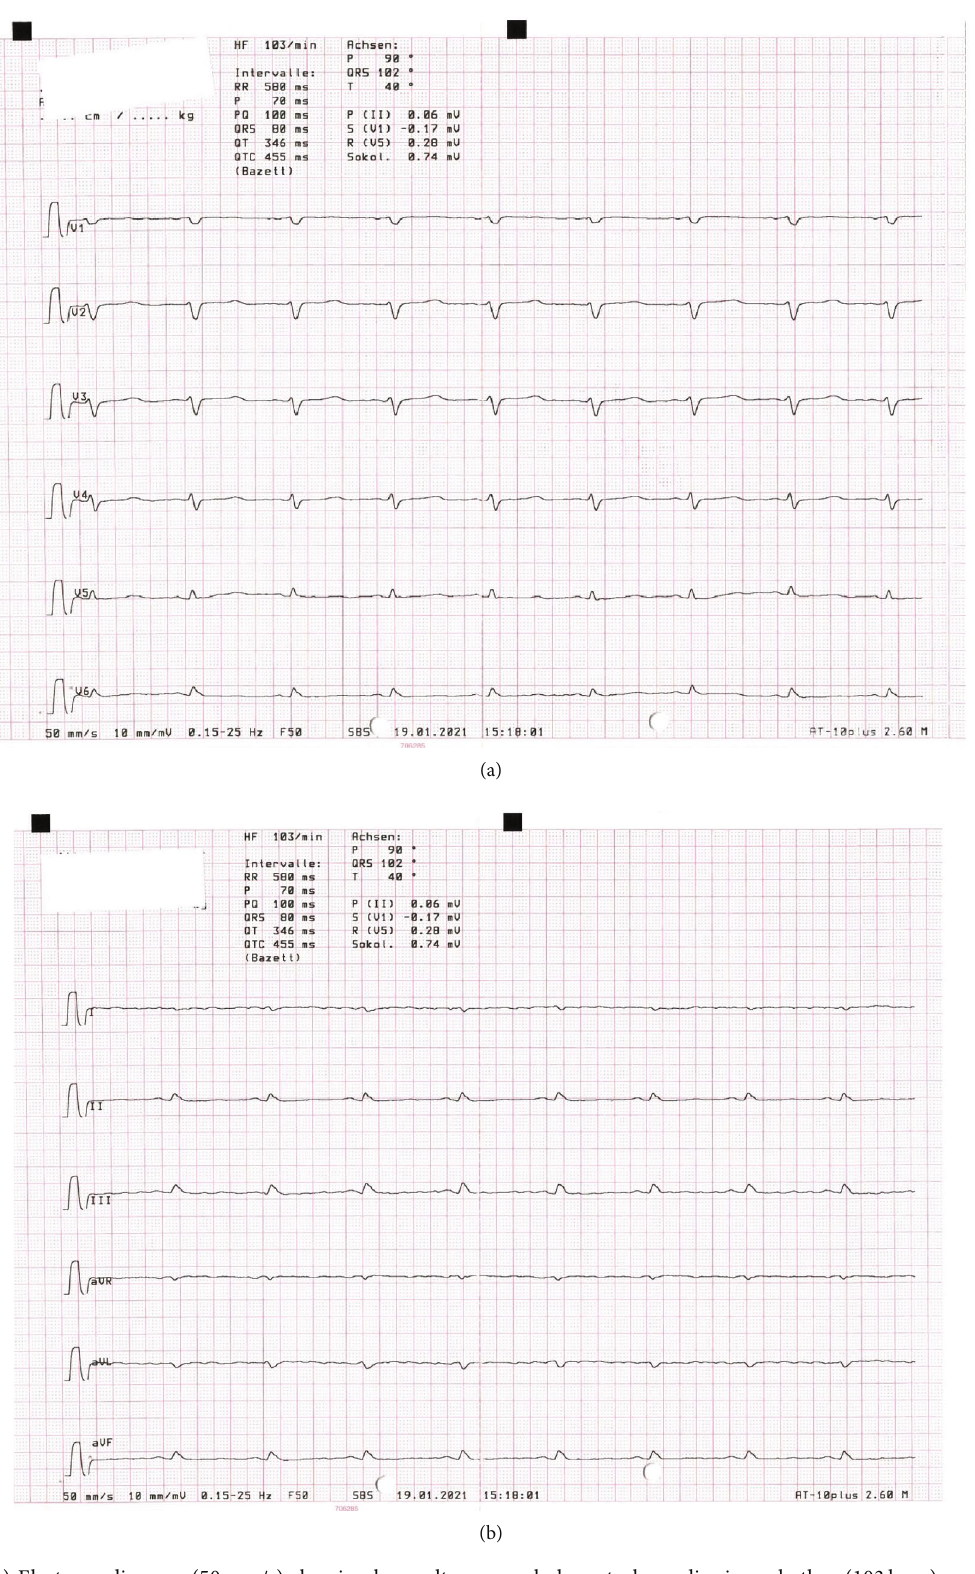
Figure 1: (a, b) Electrocardiogram (50 mm/s) showing low-voltage morphology, tachycardic sinus rhythm (103bpm), and repolarization